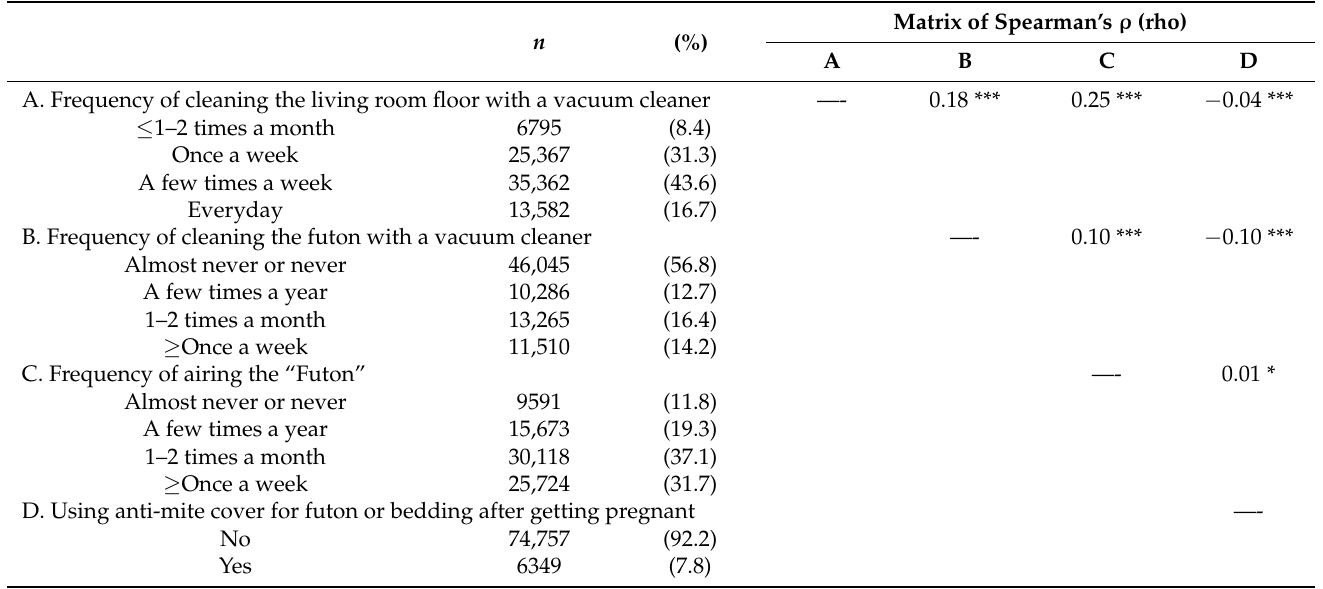
Table 2. Exposure variables with respective correlation